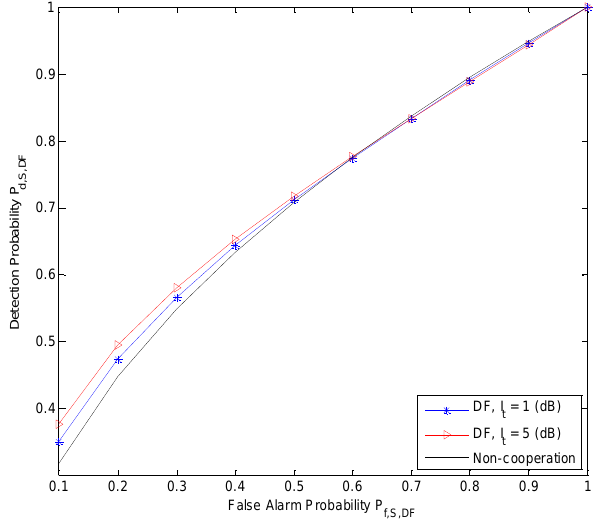
Figure 5. The ROC ( P vs. P ) of the secondary user S in the DF-CSS scheme d,S,DF f,S,DF (P = 3 dB, P = 0 D-Rx S-Rx